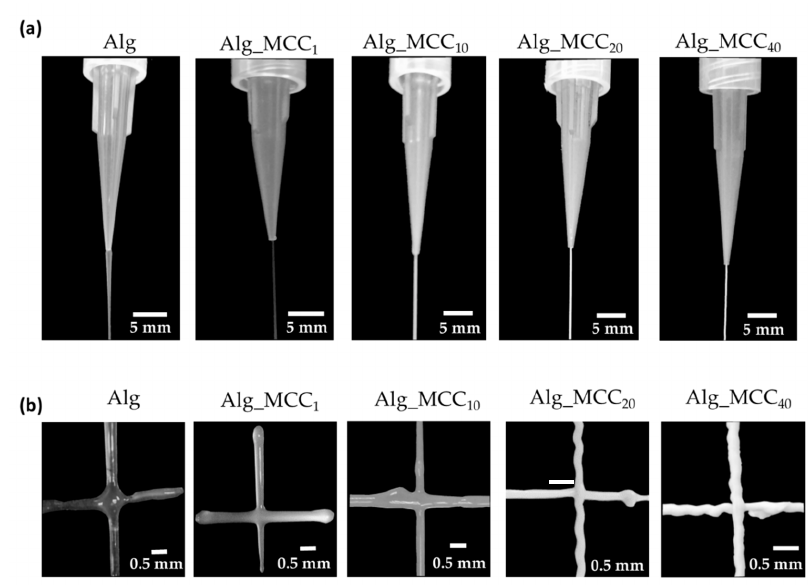
Figure 2. ( a ) The filament test and ( b ) layer stacking test of the different alginate–cellulose ink formulations. 3.3. Rheological Characterization of the Optimized Alginate ‐ Cellulose Ink